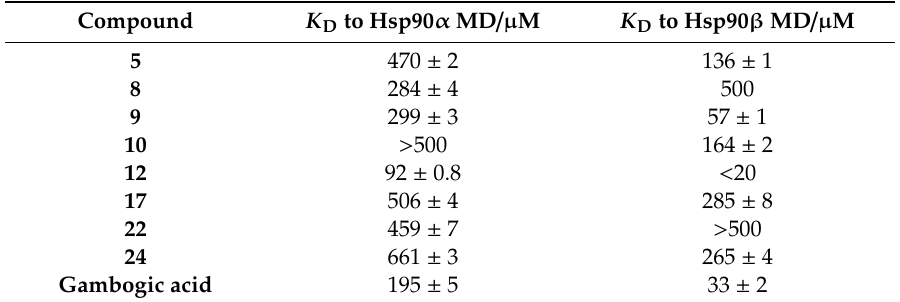
Table 1. Binding a ffi nity ( K D ) of our compounds to Hsp90 α / β MD. Gambogic acid was used as a control.